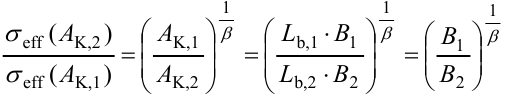
Table 5: Weibull exponent and resulting correction factor for the effective bending stress in order to incorporate the increased test surface areas. B = 360 mm